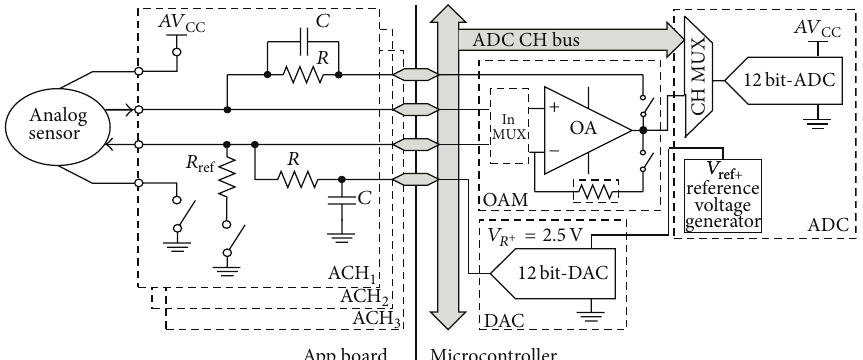
Figure 2: Analog sensor interface of the WSN